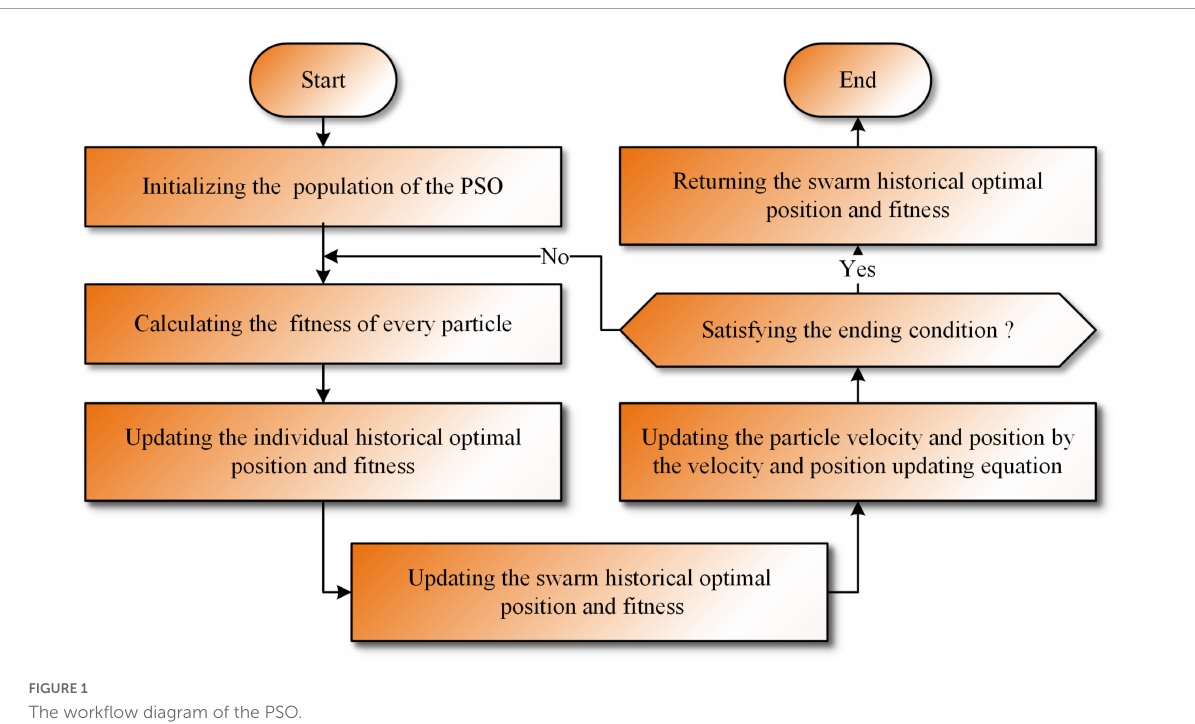
FIGURE1 The workflow diagram of the